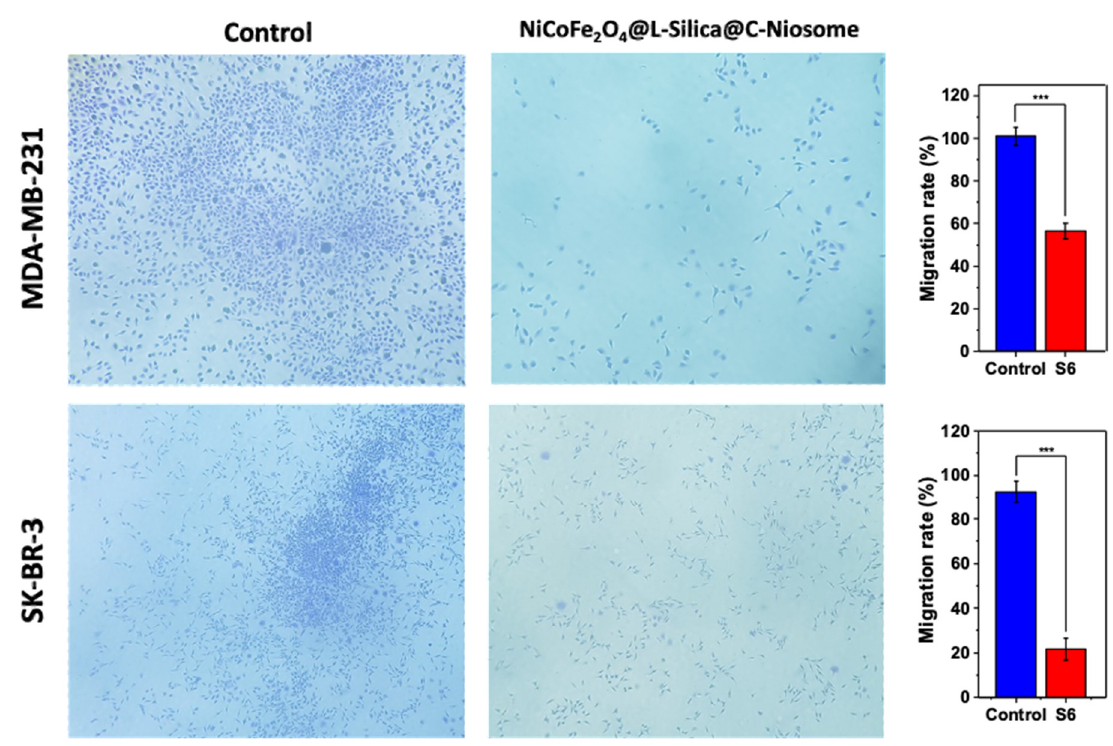
Figure 6. Migration rate in both cell lines after treatment with NiCoFe 2 O 4 @L-Silica@C-Niosome, presented as bar plots. Control: untreated cells. (*** p < 0.001). The treatment lasted 48 h for all tests at IC50 values.